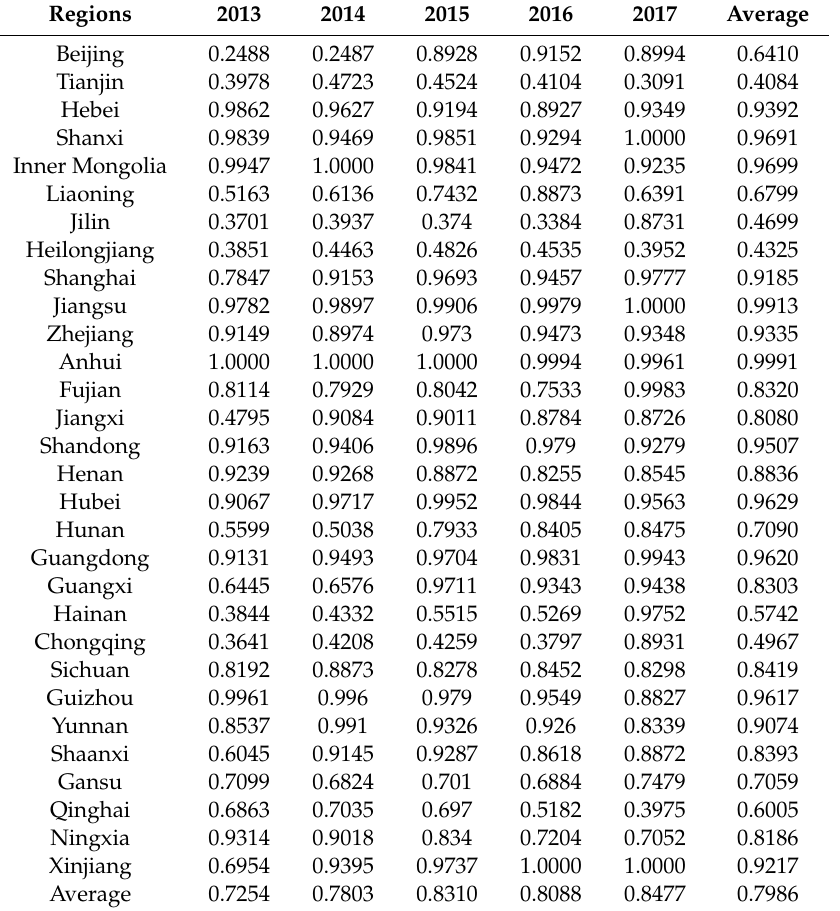
Table 5. E ffi ciencies calculated by the game cross-e ffi ciency DEA model.